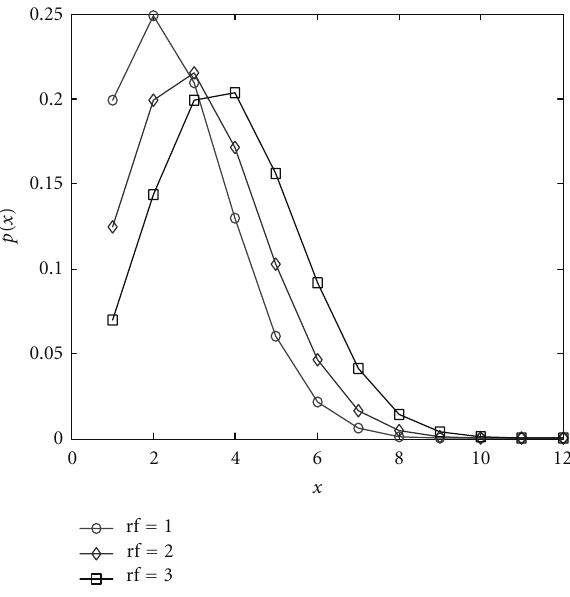
Figure 2: pdf of Rician channel and rf represent Rician